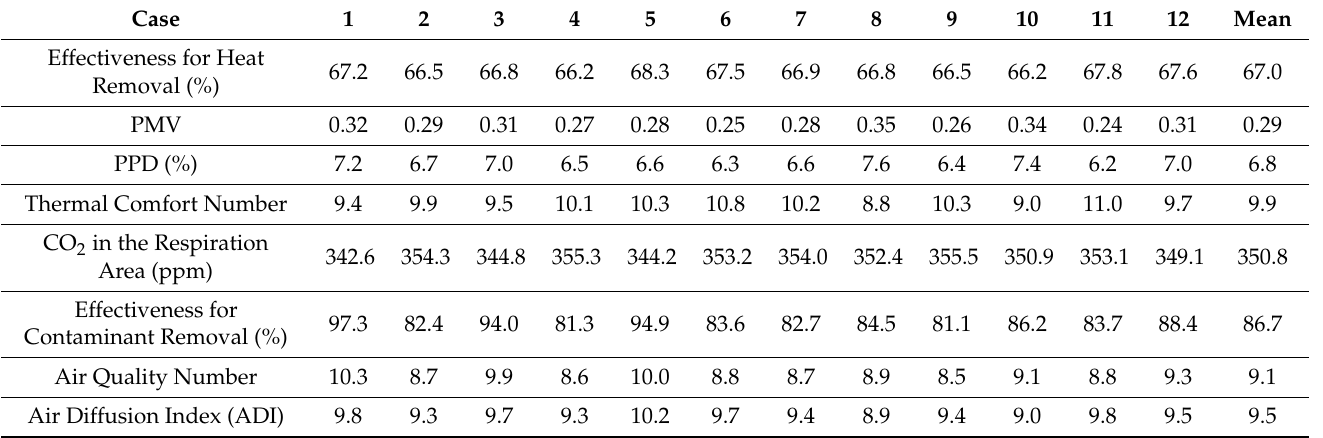
Table 12. ADI obtained for Case IV (0.1944m 3 /s) at 16 h.